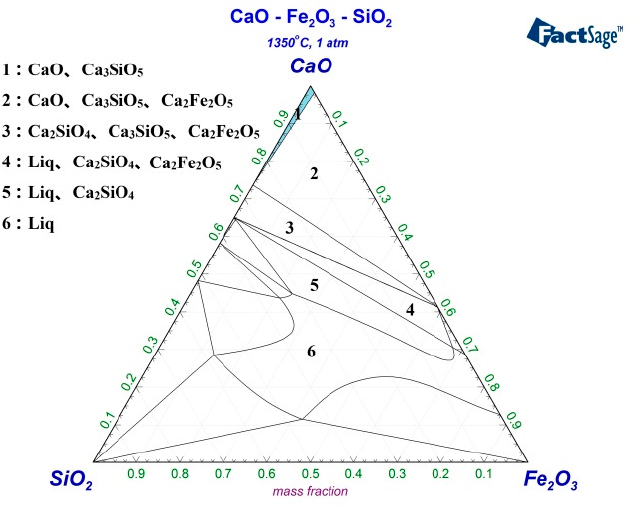
Figure 3. Equilibrium phase diagram of the Fe 2 O 3 -CaO-SiO 2 ternary system at 1350 °C.